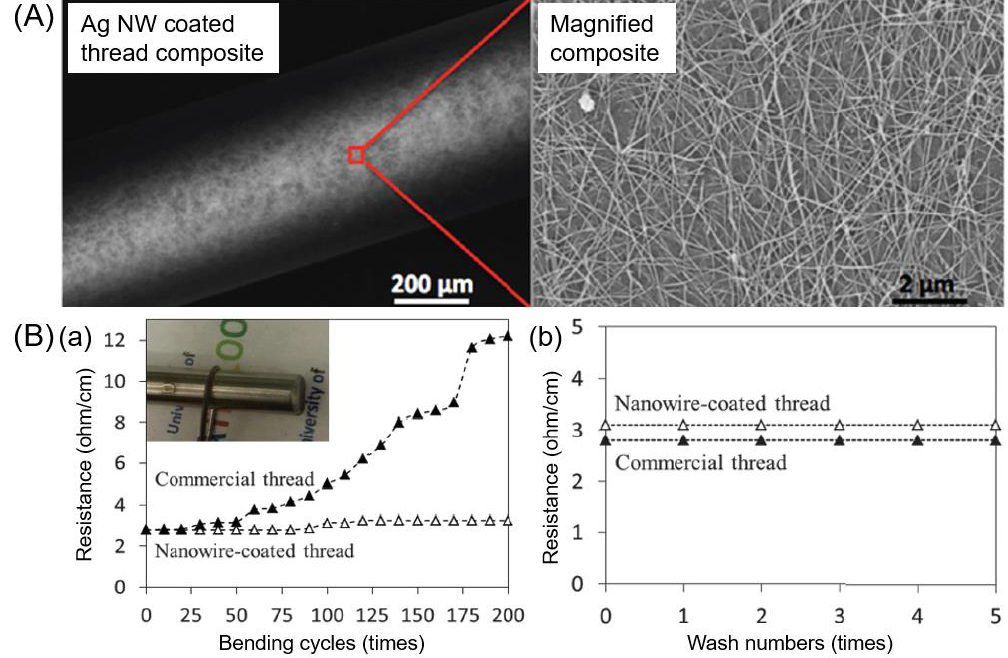
Figure 22. ( A ) SEM images of Ag NW-coated nylon thread. ( B ) Resistance of NW-coated nylon thread and a commercial thread after ( a ) repeated bending cycles at 6R and ( b ) repeated washing cycles [105].